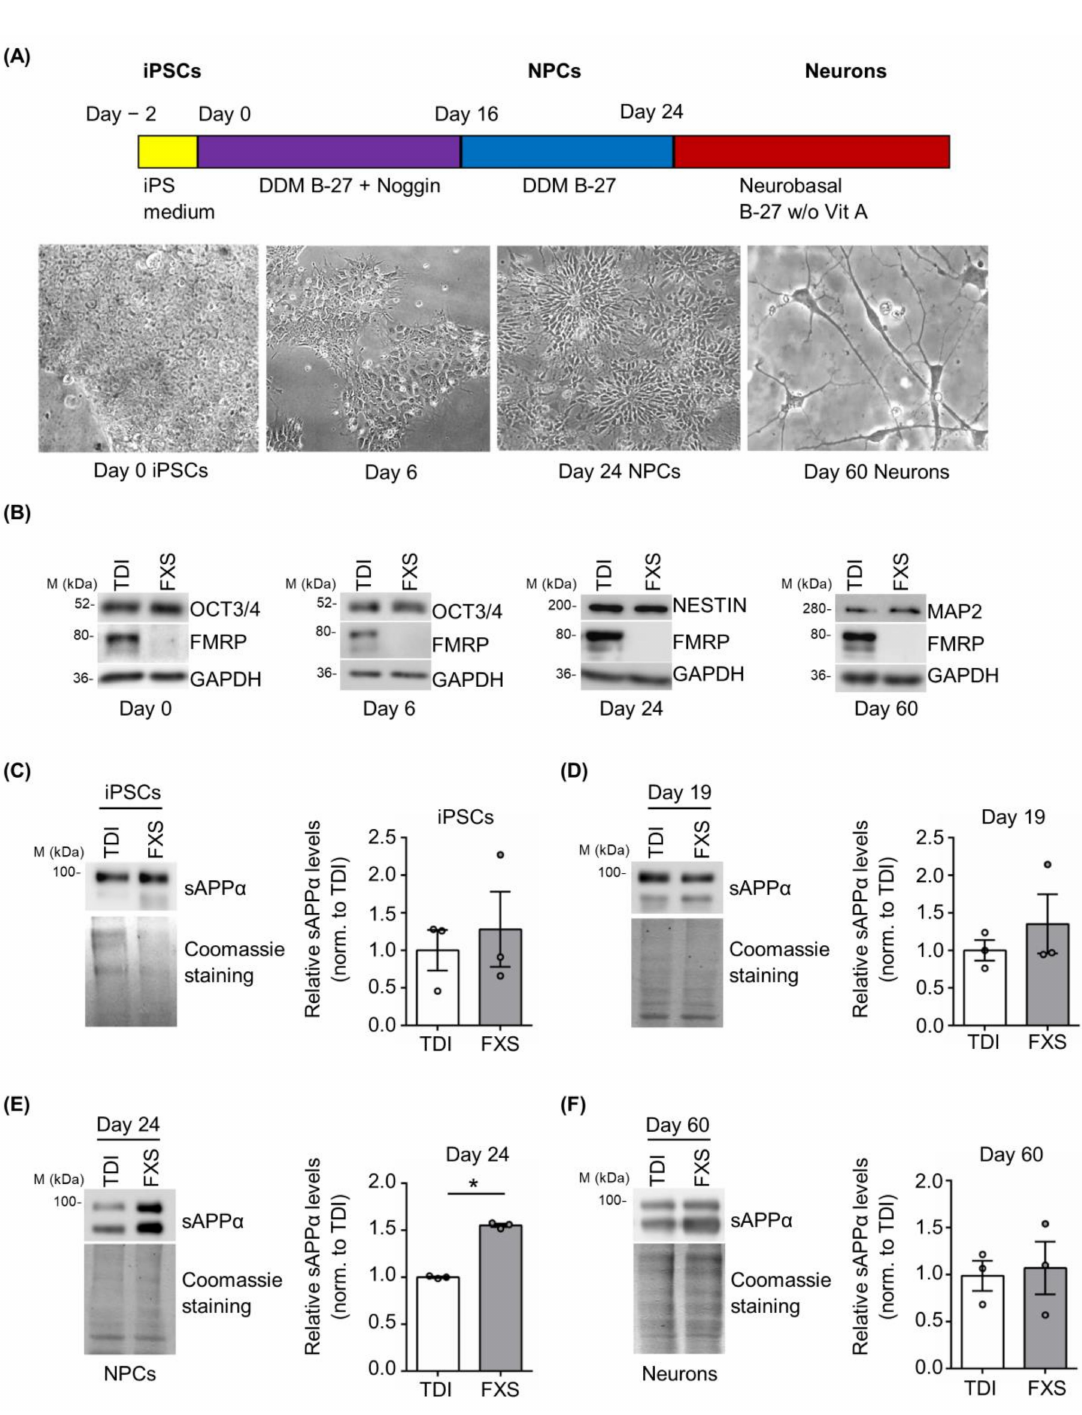
Figure 4. Expression of sAPP α during neuronal differentiation. ( A ) Schematic representation of the neural differentiation and representative bright-field microscopy images of differentiating cells. ( B ) Representative Western blots showing the expression of differentiation markers (OCT3/4, Nestin, and MAP2) during neurogenesis at day 0, day 6, day 24, and day 60. ( C – F ) Left, representative Western blots showing the level of sAPP α release in the cell media. Protein levels were measured at several neuronal differentiation stages: ( C ) iPSCs, ( D ) NPCs day 19, ( E ) NPCs day 24, and ( F ) neurons day 60 (TDI n = 3; FXS n = 3). Right, the bar plots show protein quantification normalized to Coomassie staining. Error bars represent the SEM (* p < 0.05 Mann–Whitney